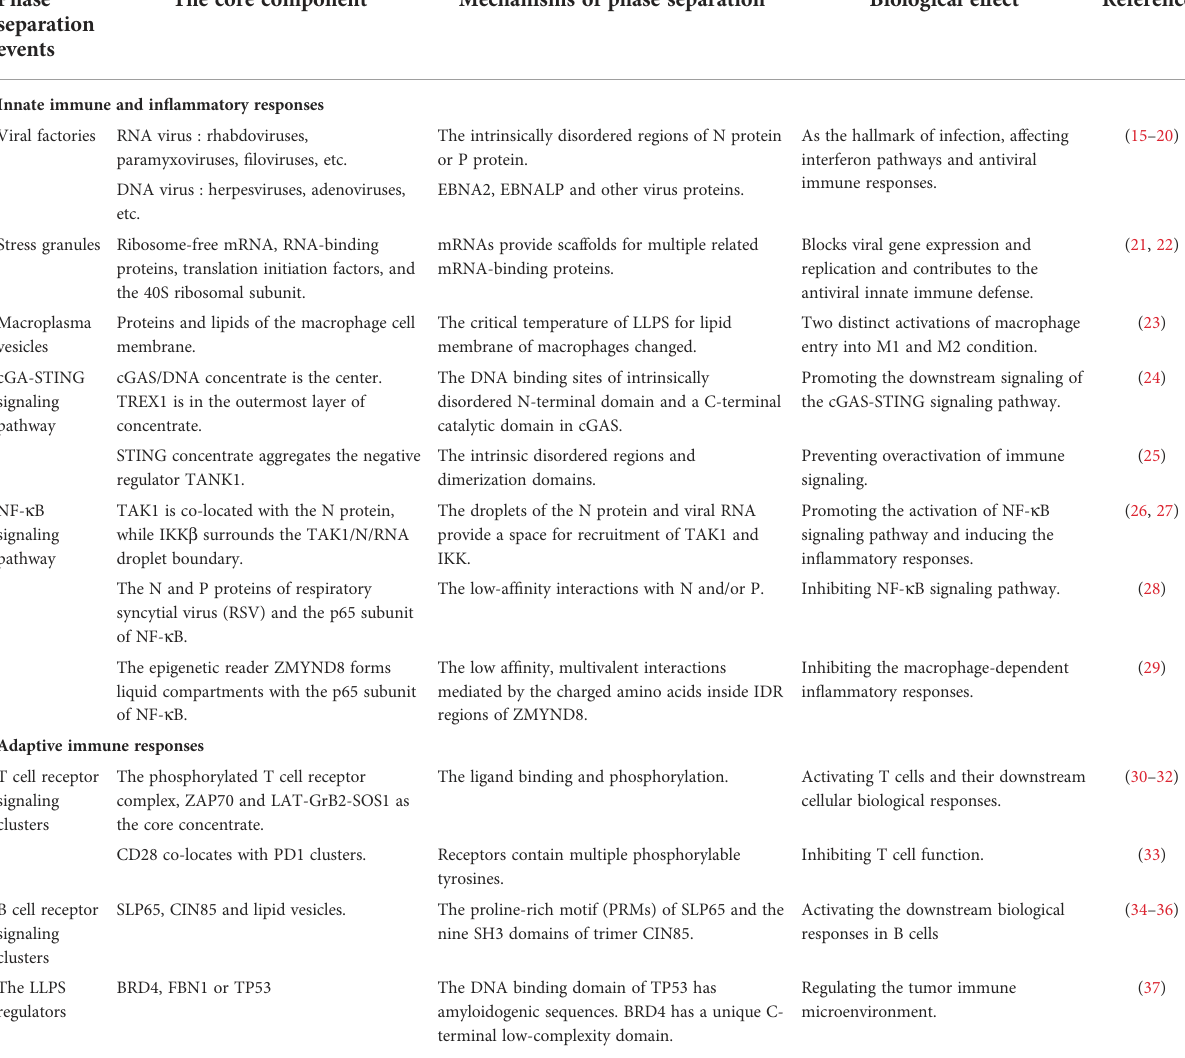
TABLE 1 Phase separation in the immune